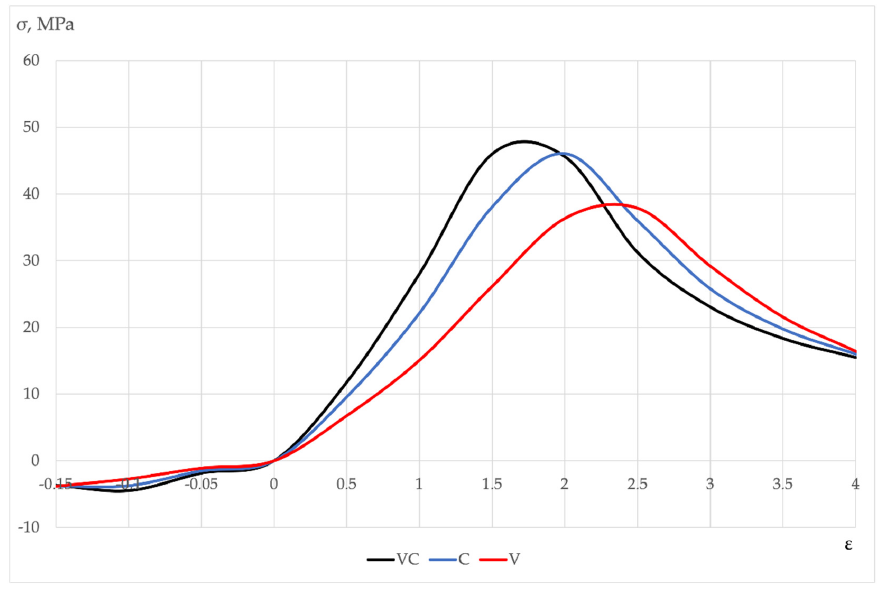
Figure 13. Relationship between concrete deformation diagrams and manufacturing technology.